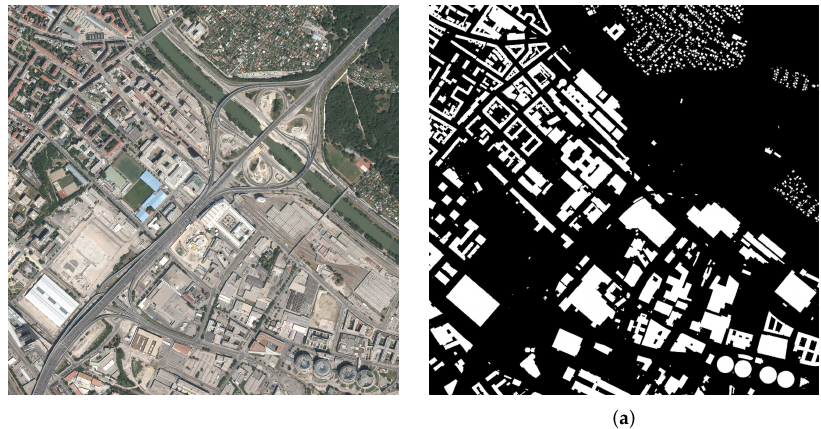
Figure 7. An example of the Inria dataset. ( a ) Original image; ( b ) Ground truth label.